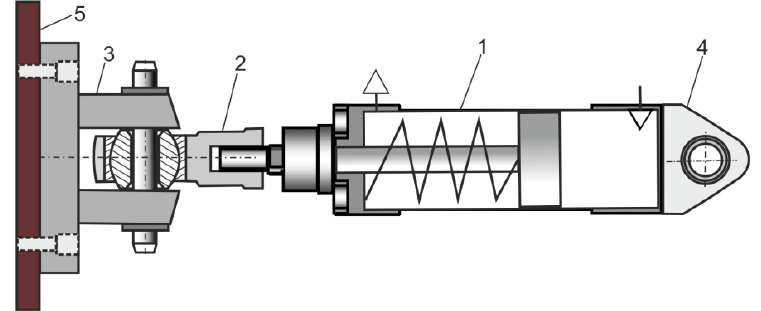
Figure 2. Design solution of a pneumatic actuator assembly: 1 –single-acting actuator, 2 – spherical rod-end, 3 – cap-end female clevis, 4 – articulated male rear hinge, 5 – contact pad.